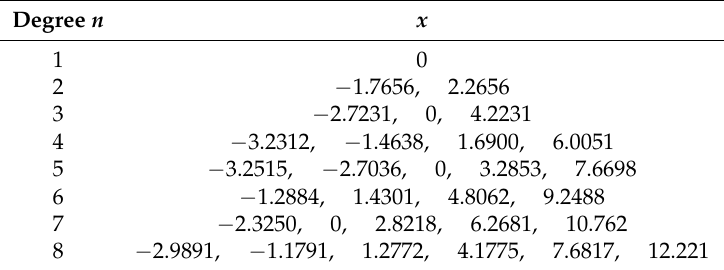
Table 2. Approximate roots of H n ( x , y , λ ) = 0, x ∈ R .